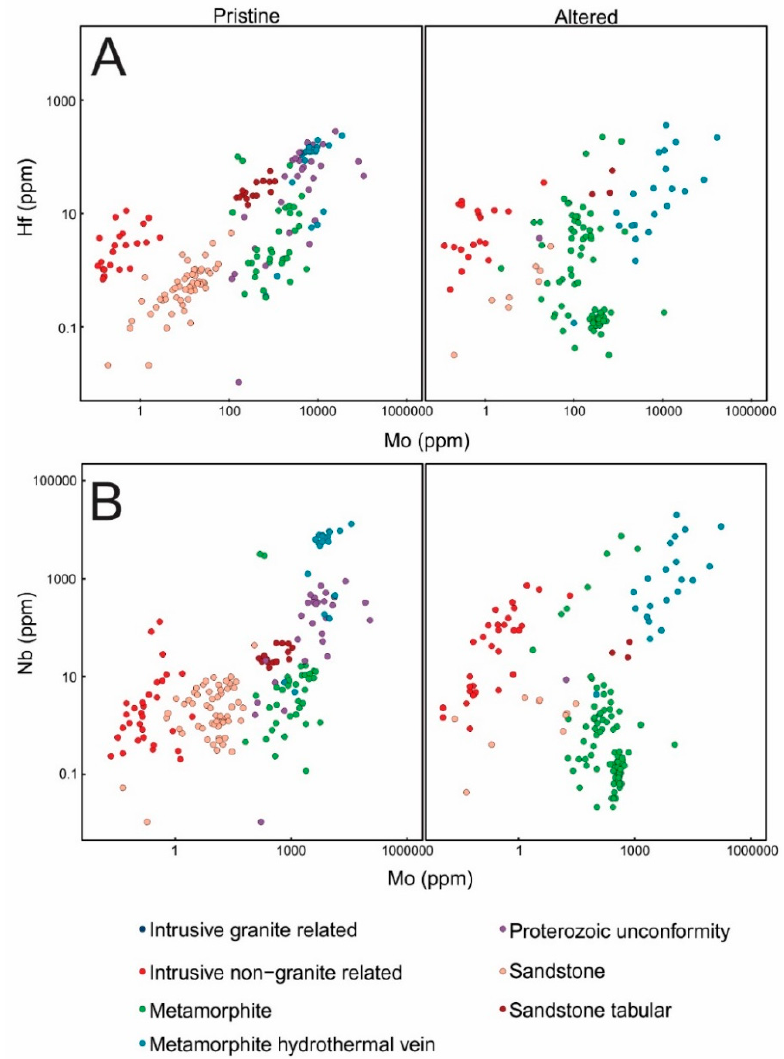
Figure 5. ( A ) Log–log plots of Hf (ppm) versus Mo (ppm) for pristine and altered uraninite samples and ( B ) Nb (ppm) versus Mo (ppm) for pristine and altered uraninite samples.